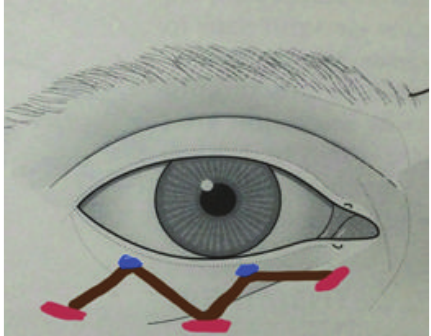
Figure 5: Drawing of the entire path of the fascia lata strip.